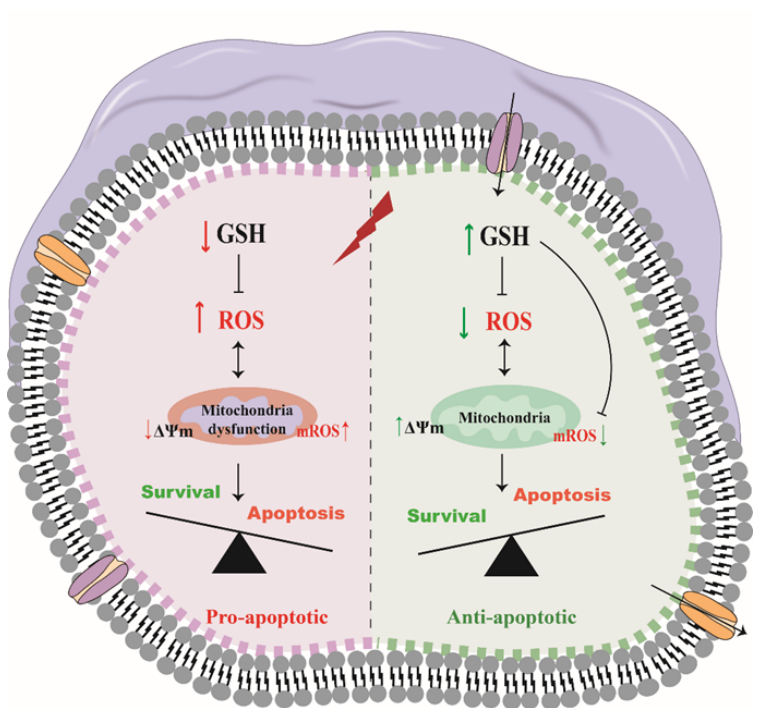
Figure 6. Mechanisms for ROS formation and GSH depletion/supplementation during oxidative stress. Oxidative stress led to increased mROS generation, which followed by a concomitant decrease in mitochondrial membrane potential (MMP). ROS accumulation and GSH depletion might further contribute to ROS-mediated apoptosis by mitochondrial dysfunction. Extracellular GSH alleviates oxidative stress via reducing mROS